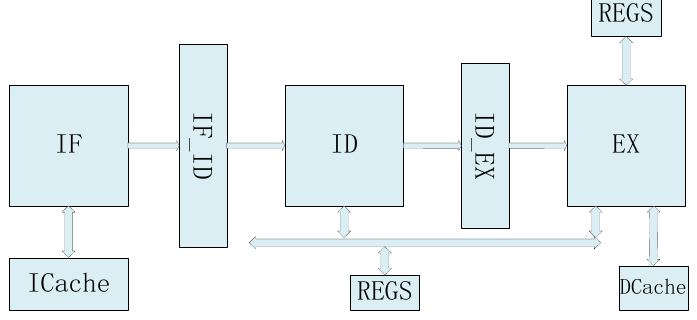
Figure 2. Simple model of the processor core (5-stage).